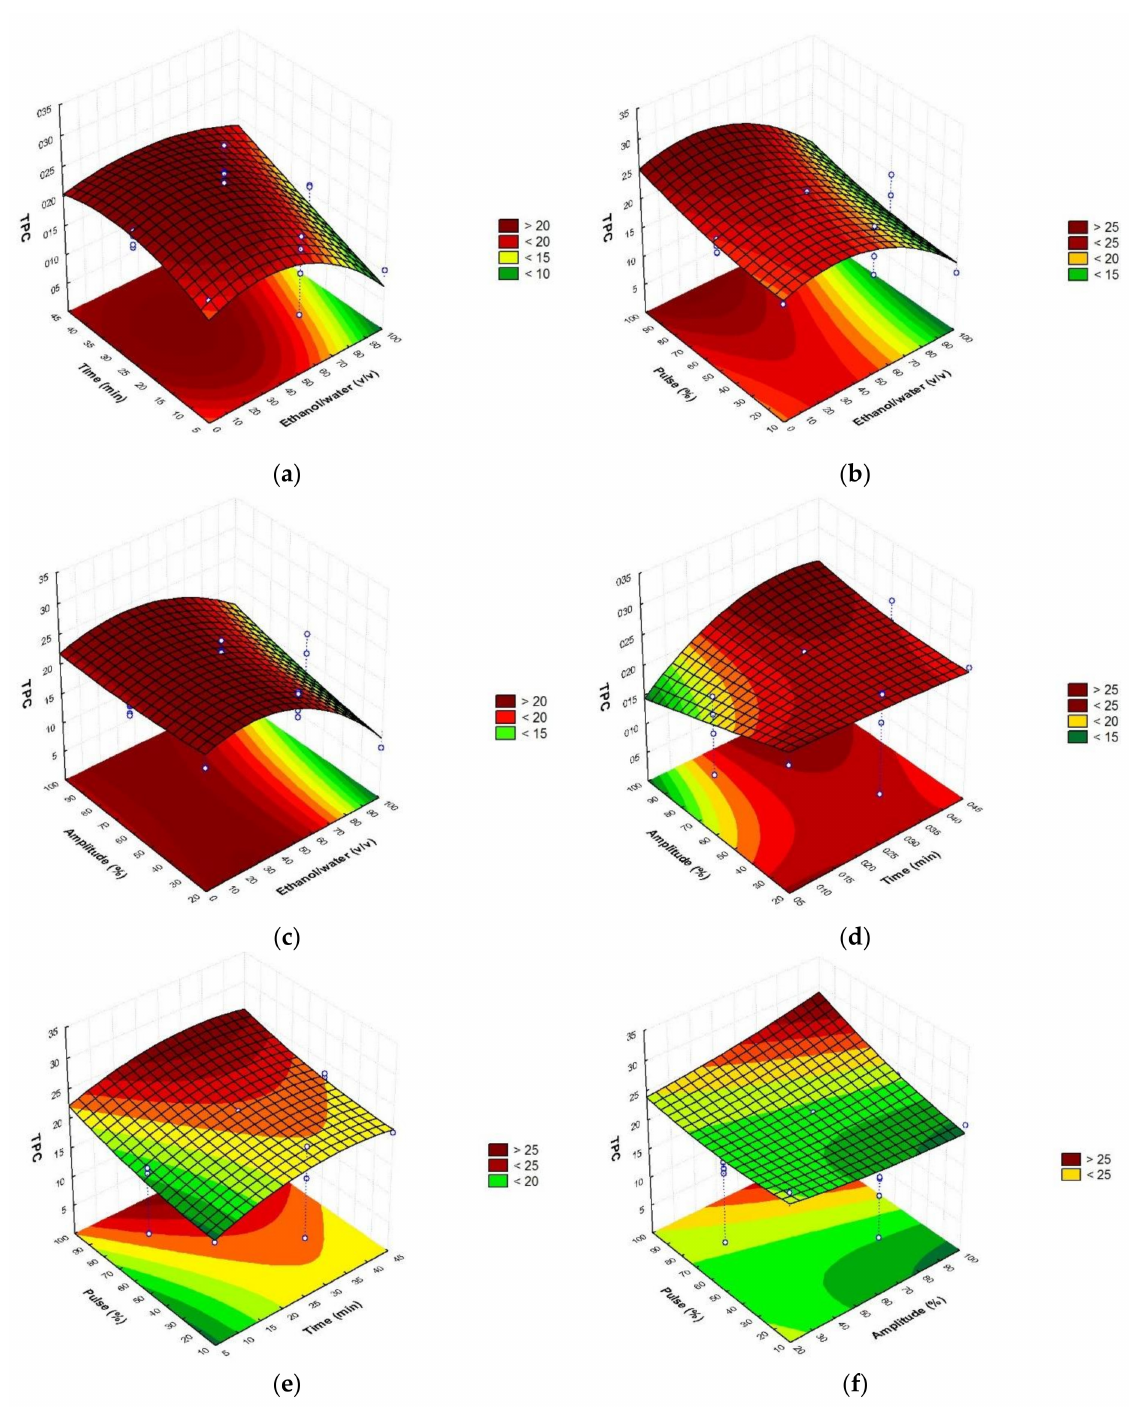
Figure 1. Response surface graphs ( a – f ) showing the combined effects of the process variables: Ethanol/water ( v / v ), time (min), amplitude (%), and pulse (%), for TPC (mg GAE/g